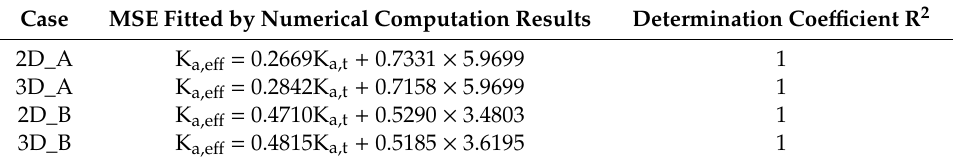
Table 1. The measurement sensitivity equation (MSE) of TDR probes.